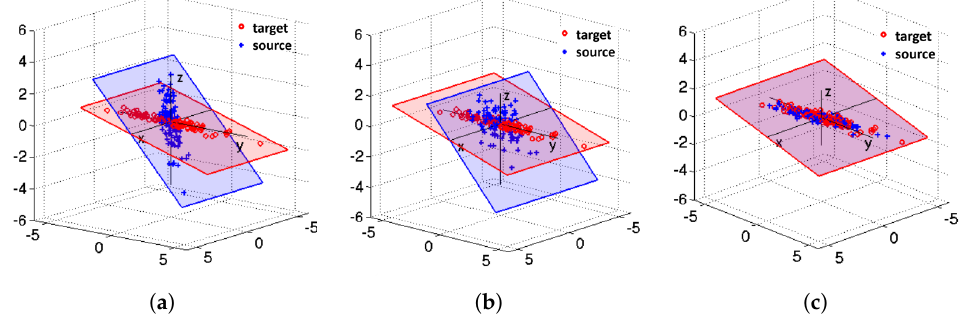
Figure 2. The process of CORAL algorithm: ( a ) the original data distributions of source domain and target domain; ( b ) the data distribution of source domain after decorrelation; ( c ) the data distribution of source domain after re-correlation using covariance of target